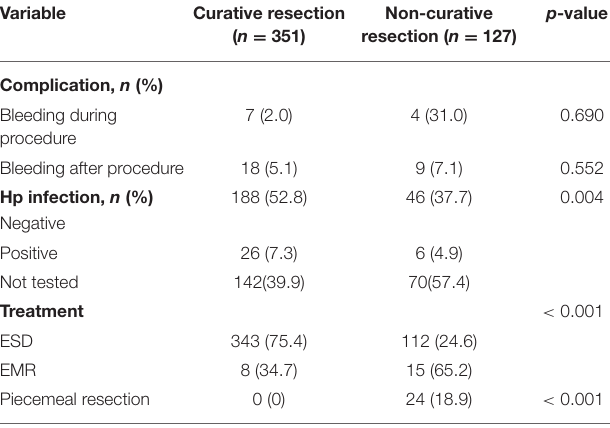
TABLE 1 | Patient’s clinicopathologic characteristics (curative resection group vs. non-curative resection